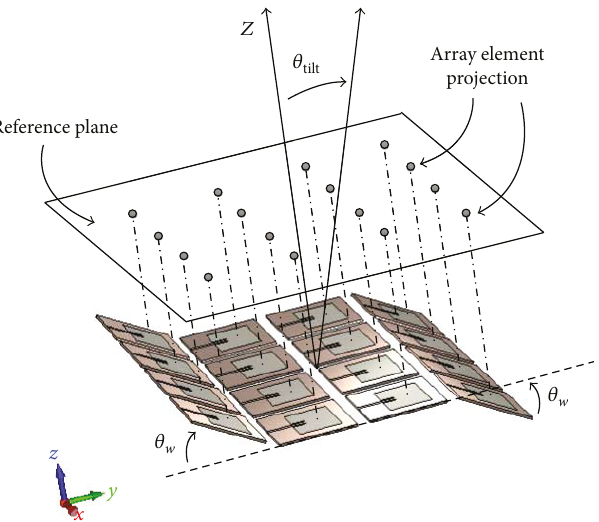
Figure 1: Investigated surface